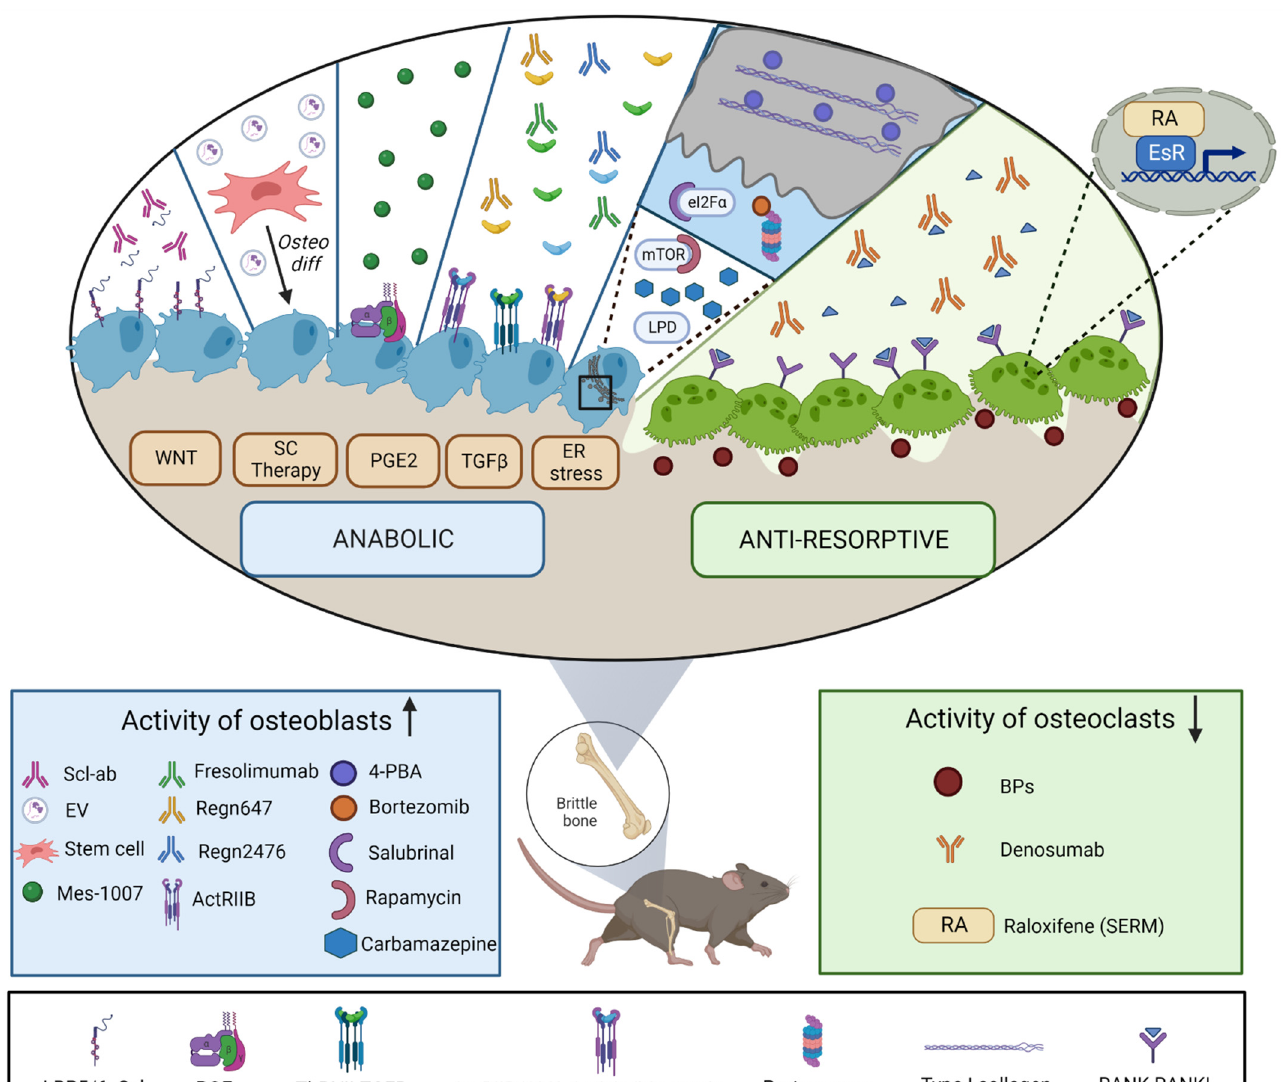
Figure 2. Treatments evaluated in OI preclinical studies to improve bone parameters of murine models. Anabolic therapies are illustrated in blue (targeting Wnt pathway, PGE2, TGFB superfamily, ER stress, or stem-cell therapy), while anti-resorptive ones are in green.